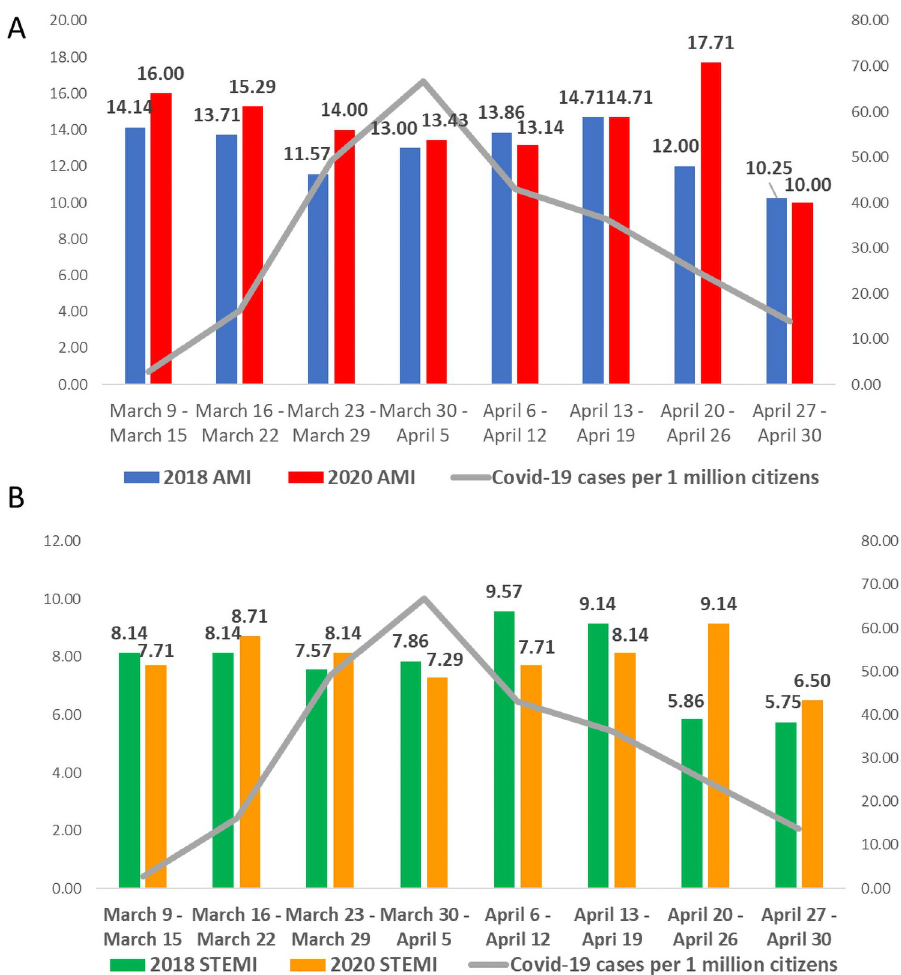
Fig 1. Daily incidence of hospitalized acute MI cases (A) and ST-segment elevation MI cases (B) before and during the Covid-19 pandemic and incidence of newly confirmed Covid-19 cases. Daily incidence of acute MI cases during 2018 (Fig 1A, blue bars) and during 2020 (Fig 1A, red bars); daily incidence of ST-segment elevation MI cases during 2018 (Fig 1B, green bars) and during 2020 (Fig 1B, yellow bars); daily incidence of newly confirmed Covid-19 cases per 1 million Israeli citizens (Fig 1A, 1B, grey line). MI = Myocardial